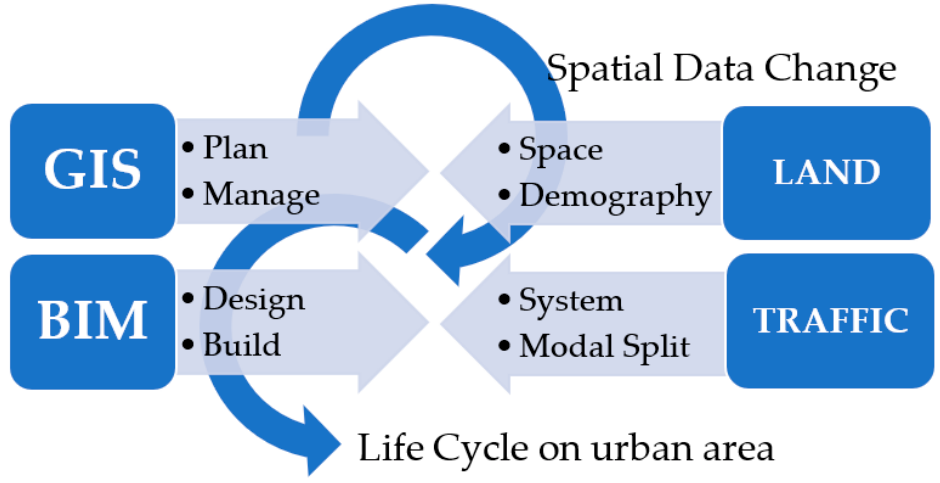
Figure 1. Scheme of binding data management in urban areas with traffic data for smart cities.